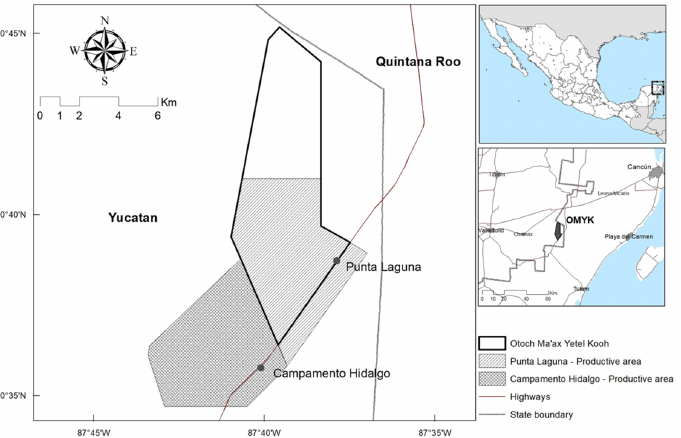
Figure 1. Location of Otoch Ma’ax Yetel Kooh (OMYK). Dashed areas represent the focal area of interest around the communities of Punta Laguna and Campamento Hidalgo where households implemented productive activities.